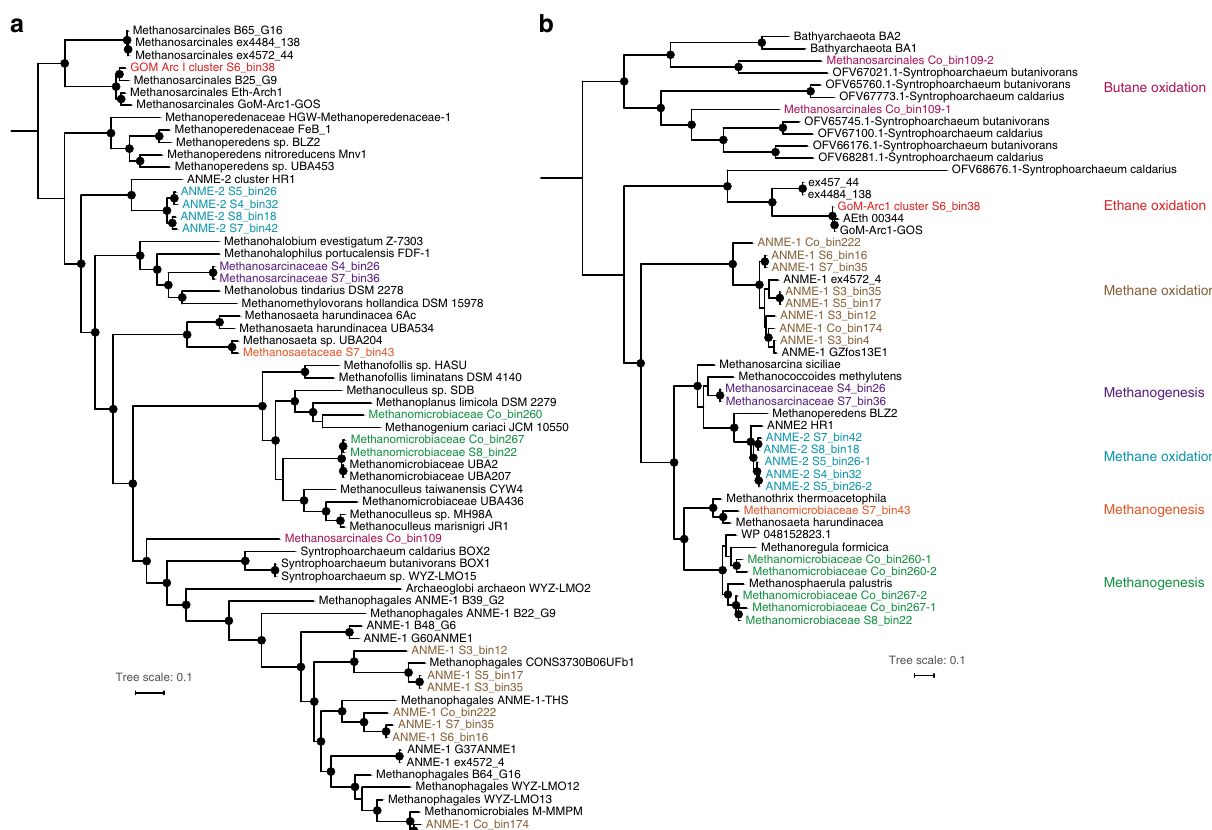
Fig. 4 Maximum-likelihood phylogenetic trees of MAGs and the detected methyl-coenzyme M reductase (McrA) sequences. a Phylogenomic tree constructed based on alignments of 43 conserved protein sequences from Methanomicrobia MAGs; b phylogenetic tree constructed based on alignments of amino-acid sequences of mcrA genes. Bootstrap values of >70% are indicated with black circles. MAGs and McrA sequences corresponding to the same alkane metabolisms are highlighted in the same color in the two trees. Scale bars correspond to percent average amino-acid substitution over the alignment, for both trees. Sequences for amino acids used to construct McrA trees can be found in Supplementary Data propane 19 . Also encoded by this MAG are heterodisul fi de reductase subunits ( hdrABC ) to reoxidize cofactors 28 , methyl-